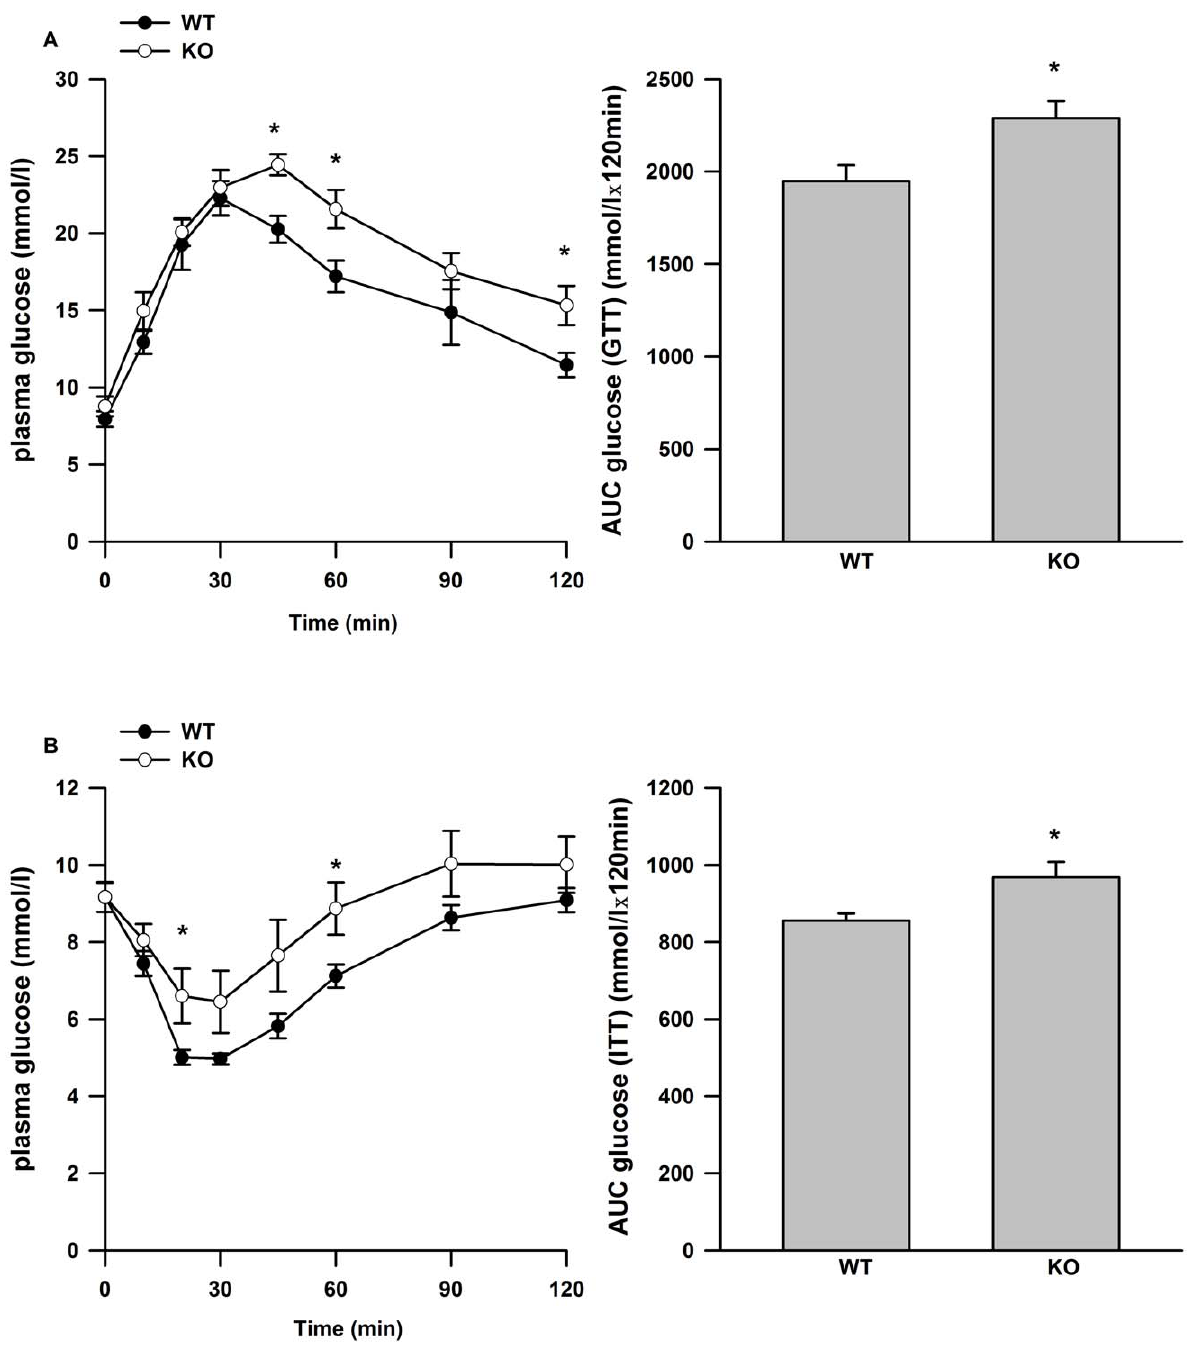
Figure 3. Glucose and insulin tolerance in WT and IL-6 2 / 2 mice fed a HFD. Glucose curves and the quantified area under the curves for glucose (A, B) and insulin (C, D) tolerance tests. Data are presented as means + SE for 8–10 mice per group. * P , 0.05 versus WT group at the same time point in A and C. * P , 0.05 versus WT group in B and D.